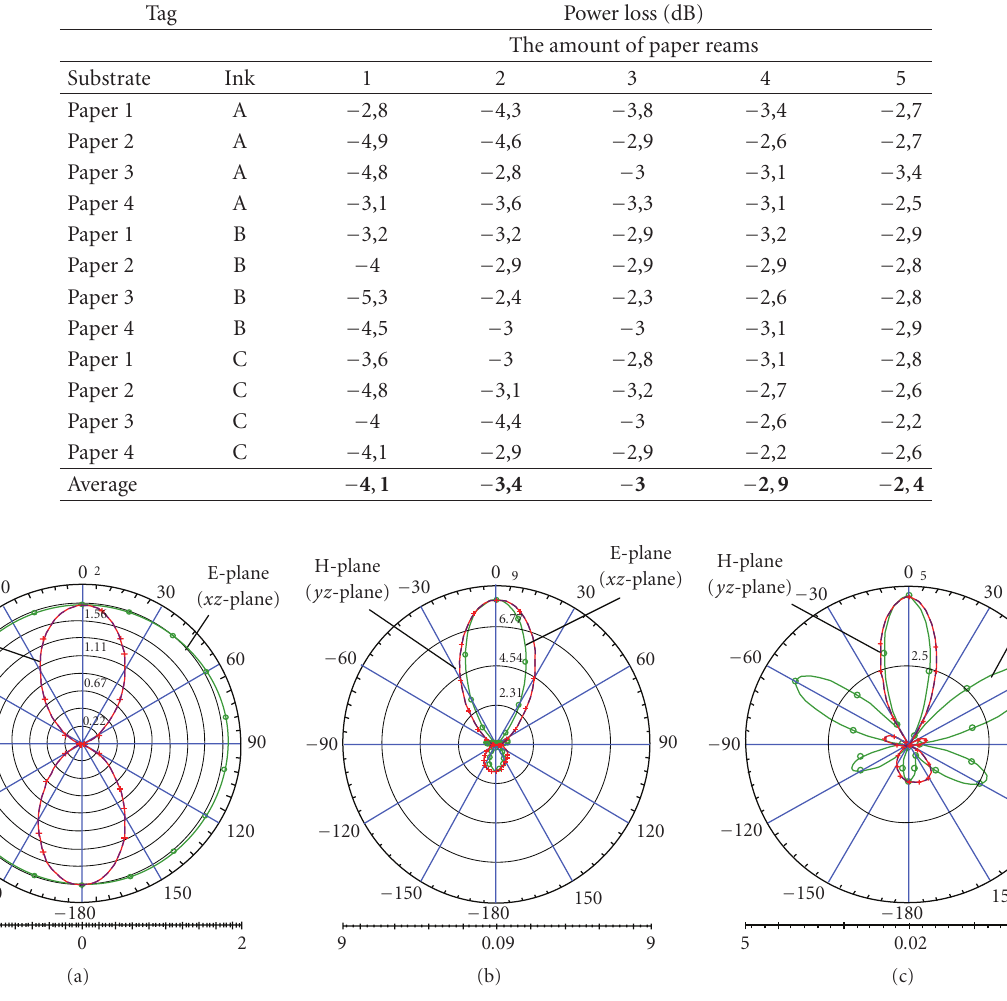
Figure 10: The radiation patter of a bow-tie tag: (a) in air, (b) behind three paper reams, and (c) behind five paper reams